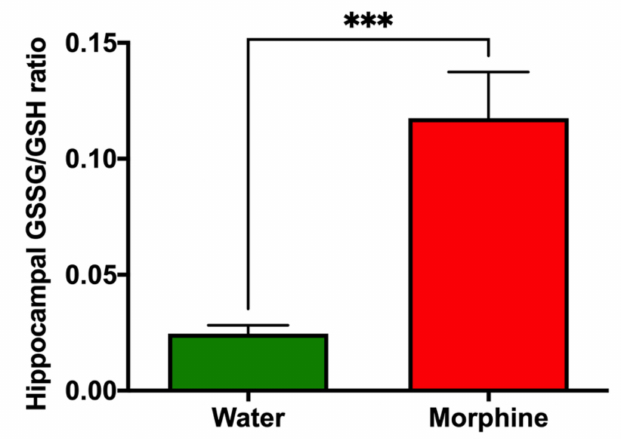
Figure 7. Voluntary morphine intake induces hippocampal oxidative stress in Wistar rats. Hip- pocampal oxidized/reduced glutathione ratio (GSSG/GSH) in rats that had voluntarily ingested morphine for four weeks. Animals drinking only water were used as controls. Data are expressed as mean ± SEM. n = 8 in each experimental group. *** p < 0.001, two-tailed Student t -test.